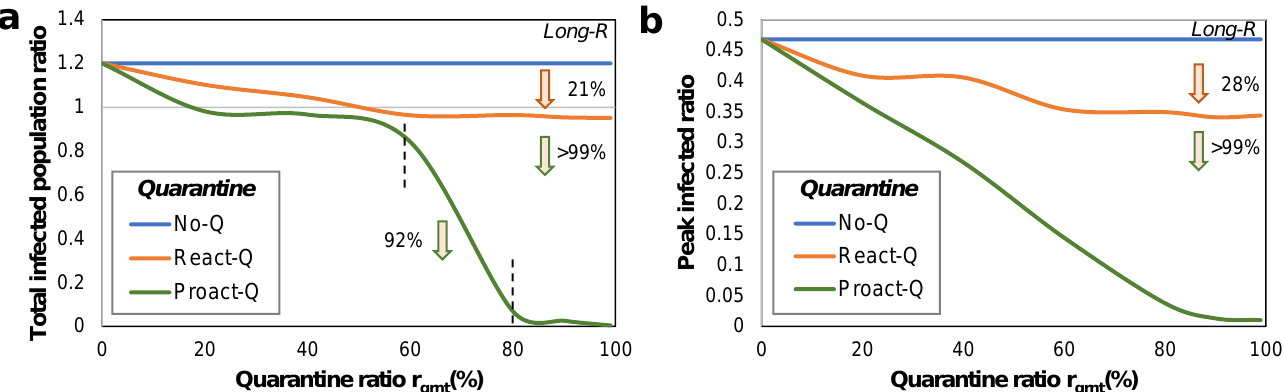
Figure 4. Impact of each quarantine policy in terms of an increasing quarantine ratio r qrnt . ( a ) The total infected population ratio measured as the sum of all new cases throughout the simulation until the epidemic dissipates. The two vertical dotted bars delimit the phase transition area between r qrnt = 0.6–0.8. ( b ) The peak infection ratio expressed as the maximum amplitude of the epidemic wave relative to the population of agents. The percentages along the right border of each panel represent relative decreases from the maximum to the minimum infected ratio.